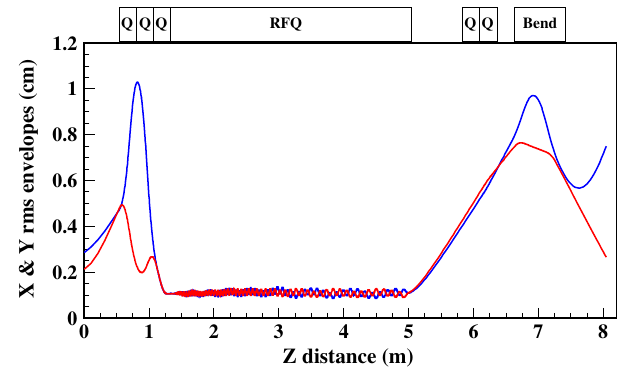
FIG. 15. Calculated beam rms envelopes in the section from the emittance probe to the high-dispersion image plane ( X : blue line; Y : red line) for an rms-normalized emittance of 0 : 083 (cid:3) mm mrad